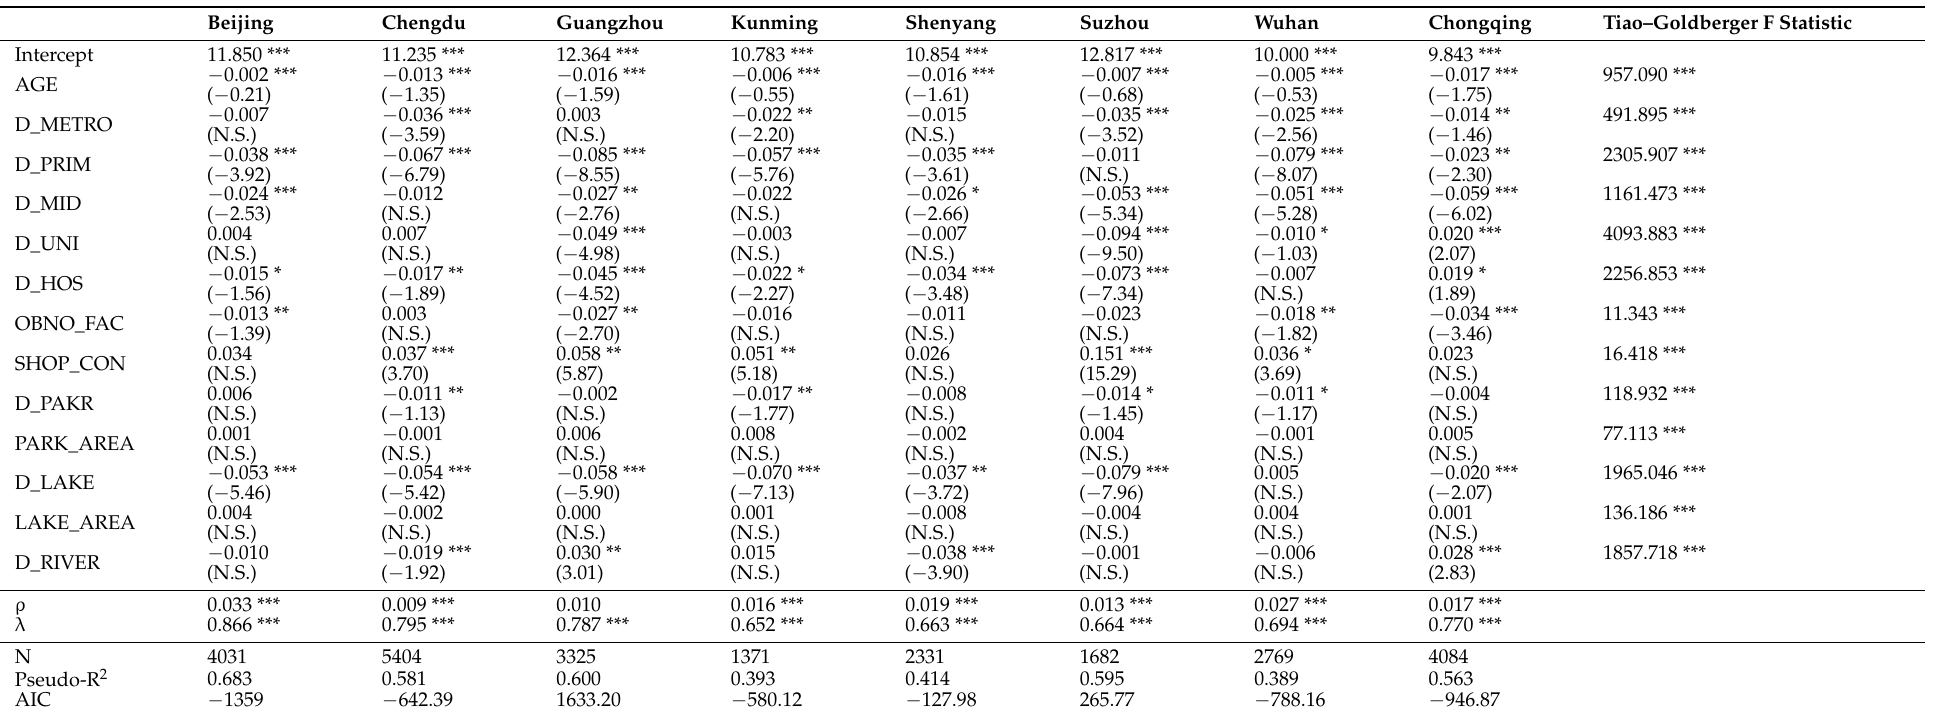
Table 3. Spatial autoregressive combined (SAC) estimation and marginal implicit price results for Model